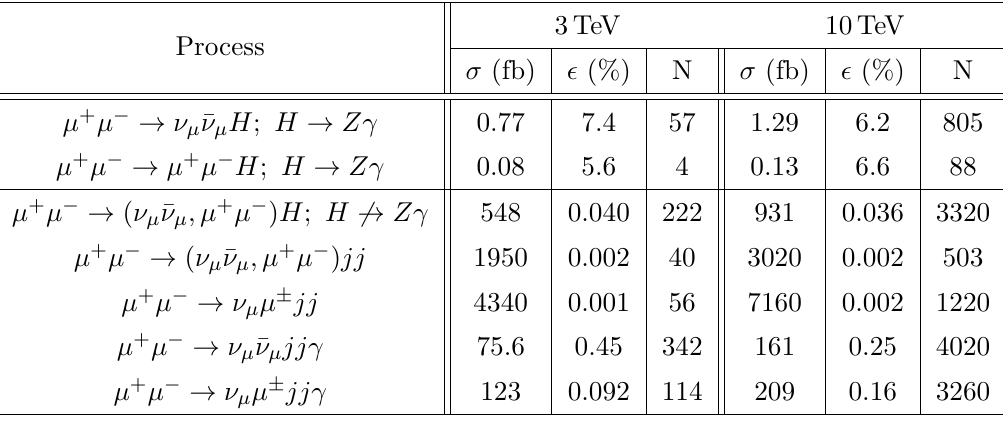
Table 6 . Signal and most important backgrounds for the hadronic H → Zγ decay mode, after applying the cuts listed in the text. Processes without an explicit γ have had the photon generated from